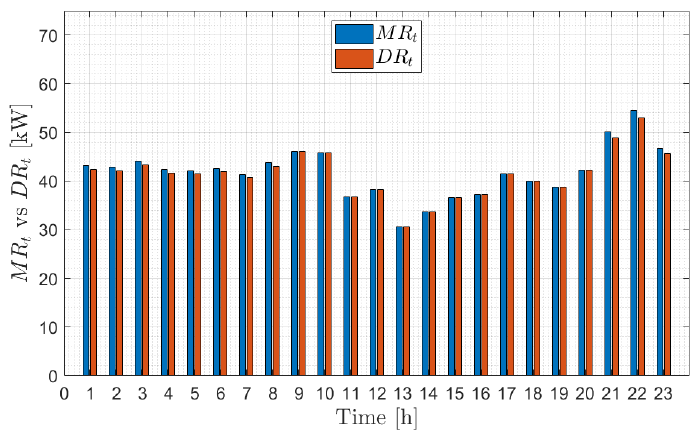
Figure 6. Electrical and thermal demand of the LU number 4 (microgrid).